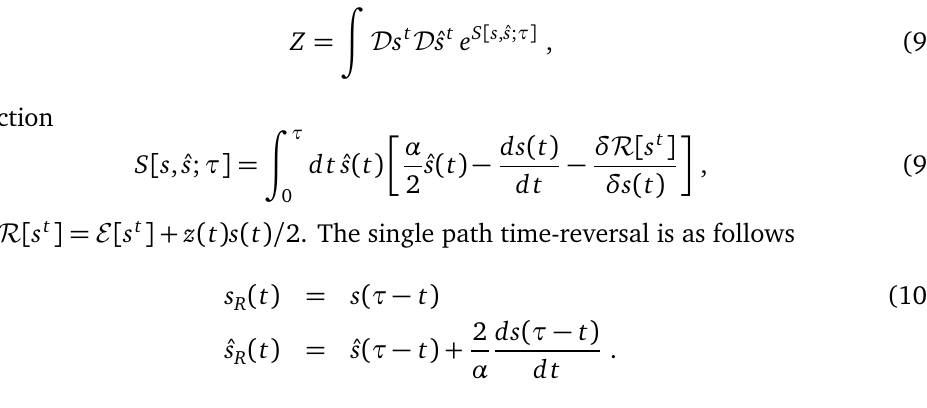
Energies along the relaxation = − 1.1555 and reach ε = − 1.167 2 1